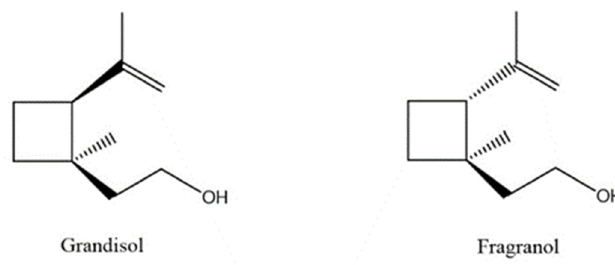
Figure 2. Fragranol and its diastereomers grandisol. Table 1. Compositions of the leaf EOs obtained from the eight wild samples of Achillea ligustica (1– 8) and a cultivated one (9).